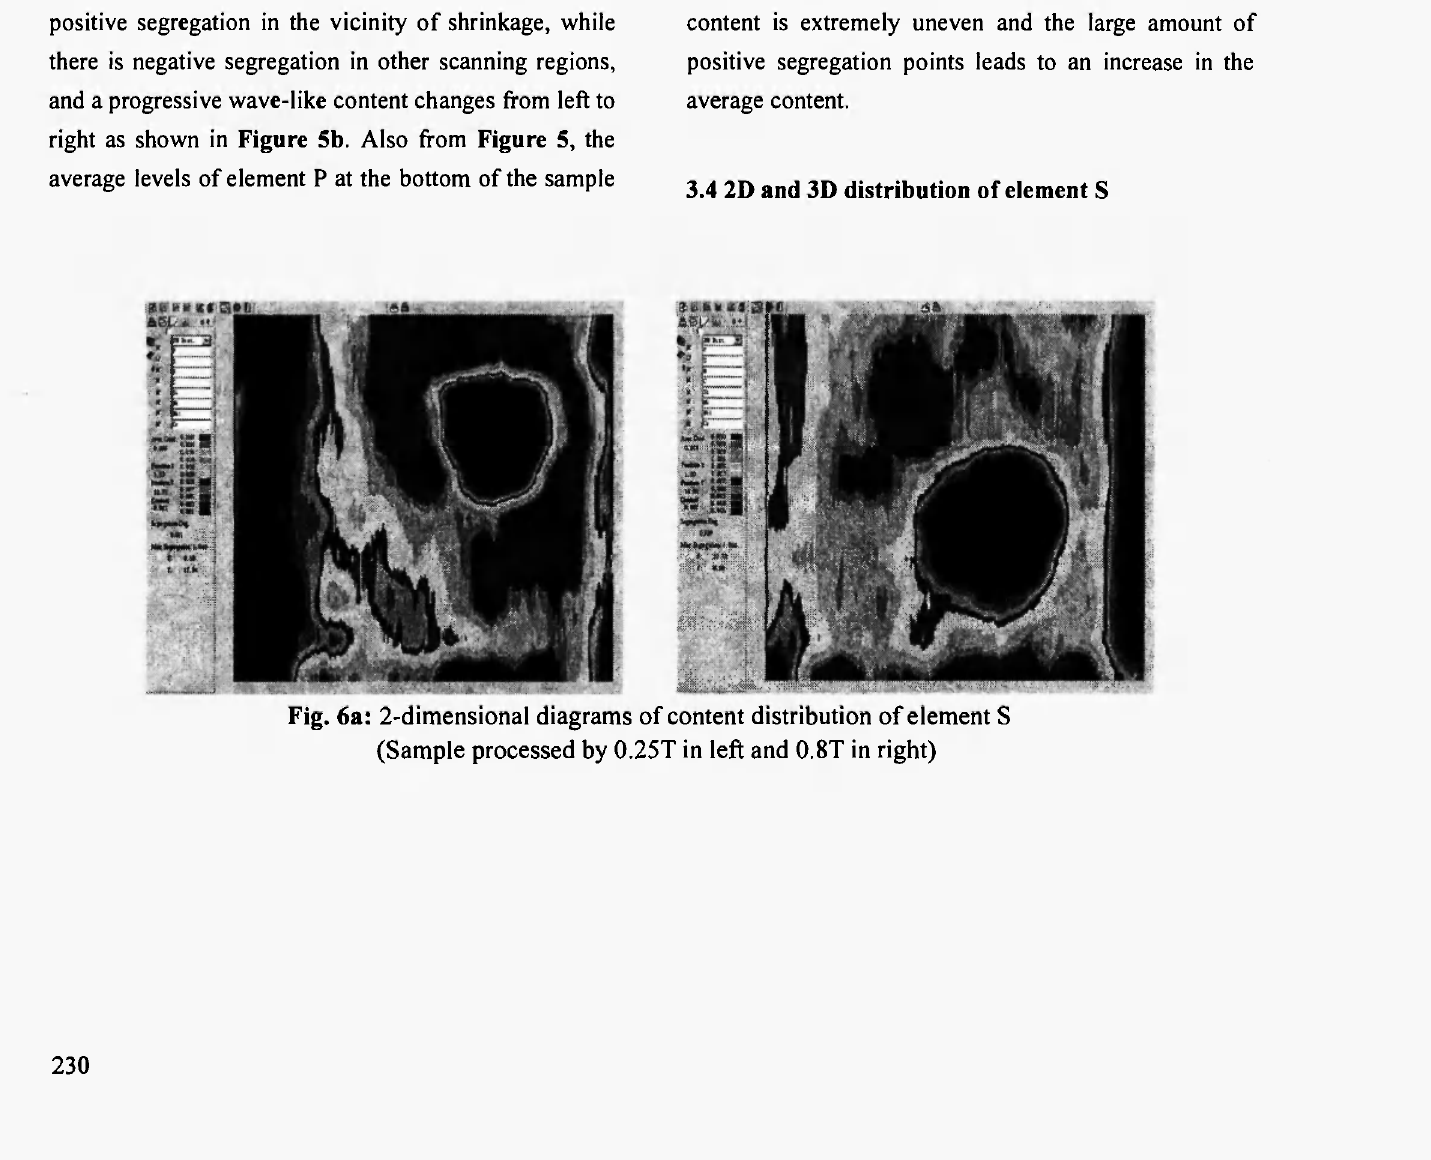
Fig. 5b: 3-dimensional diagrams of content distribution of element Ρ (Sample processed by 0.25T in left and 0.8T in right)